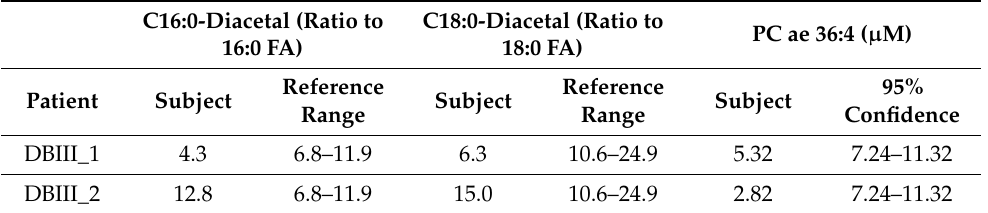
Table A5. D-BPIII patient with irregularly low GC-MS plasmalogen markers can still be identified as different to ZSS patients, but also controls, by the FIA-MS marker PC ae 36:4. Red blood cell membrane plasmalogen from D-BPIII patient was analyzed using GC-MS and serum from the same sample was analyzed using the Biocrates AbsoluteIDQ p180 kit. For reference range the 95% confidence interval from 28 controls was used.